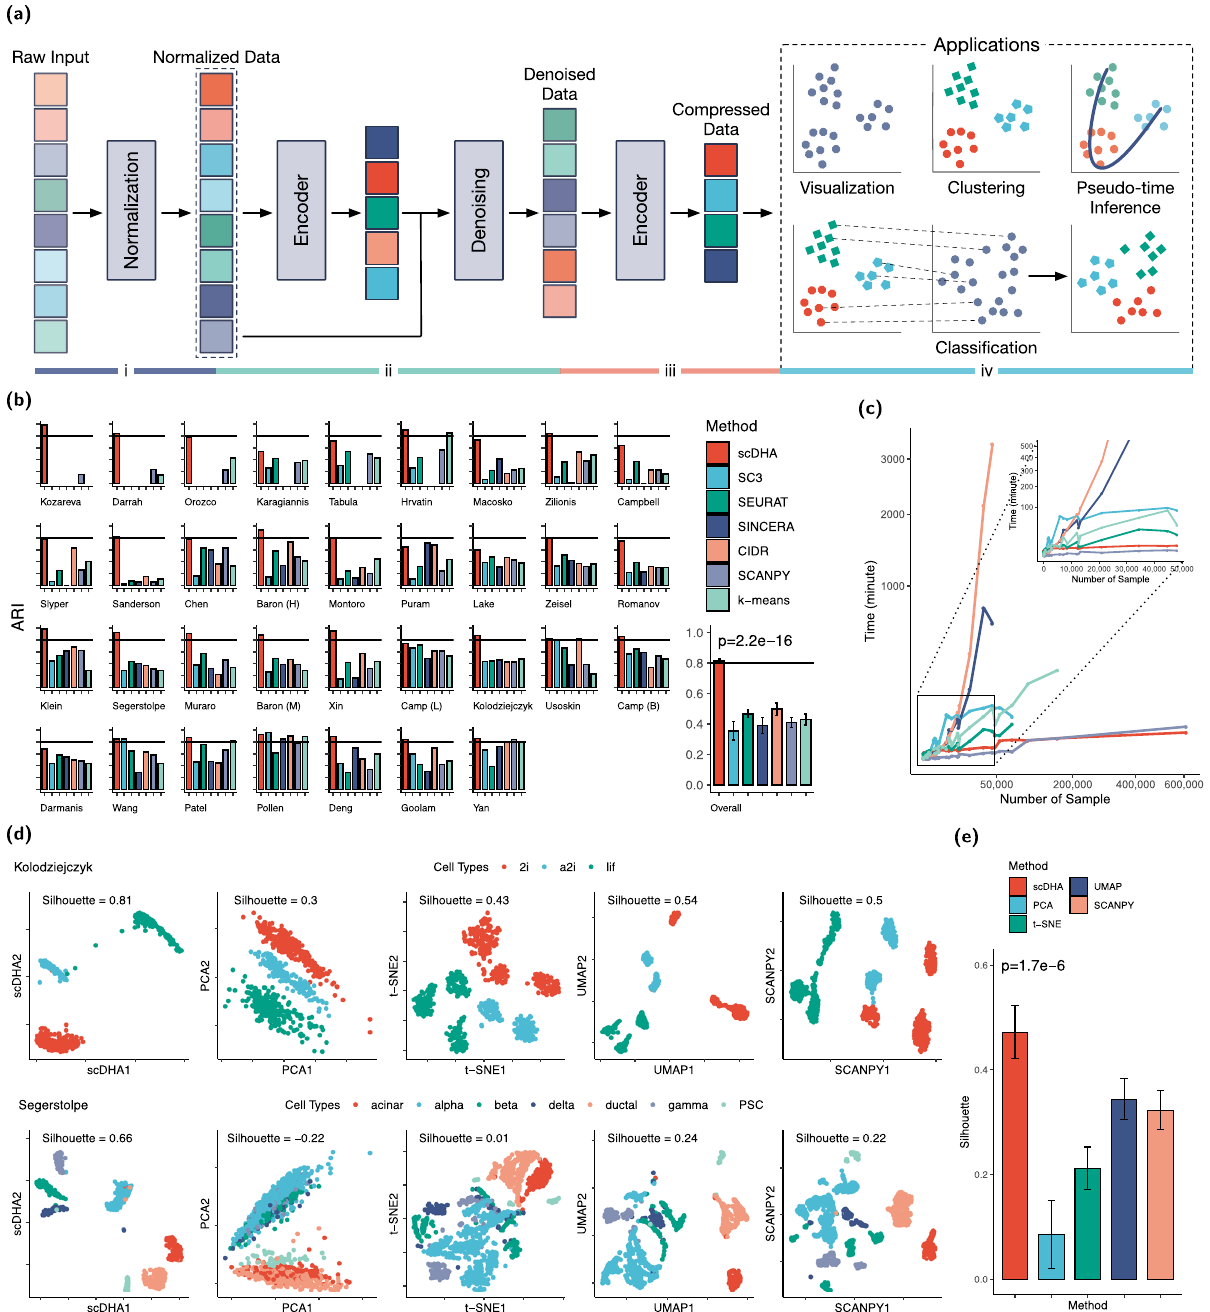
Fig. 1 Overview of scDHA architecture and analysis performance on 34 scRNA-seq data sets. a Schematic overview of scDHA and applications: cell segregation through unsupervised learning, visualization, pseudo-temporal ordering, and cell classi fi cation. b Clustering performance of scDHA, SC3, SEURAT, SINCERA, CIDR, SCANPY, and k-means measured by adjusted Rand index (ARI). The fi rst 34 panels show the ARI values obtained for individual data sets whereas the last panel shows the average ARIs and their variance (vertical segments). scDHA signi fi cantly outperforms other clustering methods by having the highest ARI values ( p = 2.2 × 10 − 16 using one-sided Wilcoxon test). c Running time of the clustering methods, each using 10 cores. scDHA is the fastest among the six methods. d Color-coded representation of the Kolodziejczyk and Segerstolpe data sets using scDHA, PCA, t-SNE, UMAP, and SCANPY (from left to right). For each representation, we report the silhouette index, which measures the cohesion among cells of the same type, as well as the separation between different cell types. e Average silhouette values (bar plot) and their variance (vertical lines). scDHA signi fi cantly outperforms other dimension reduction methods by having the highest silhouette values ( p = 1.7 × 10 − 6 using one-sided Wilcoxon test).